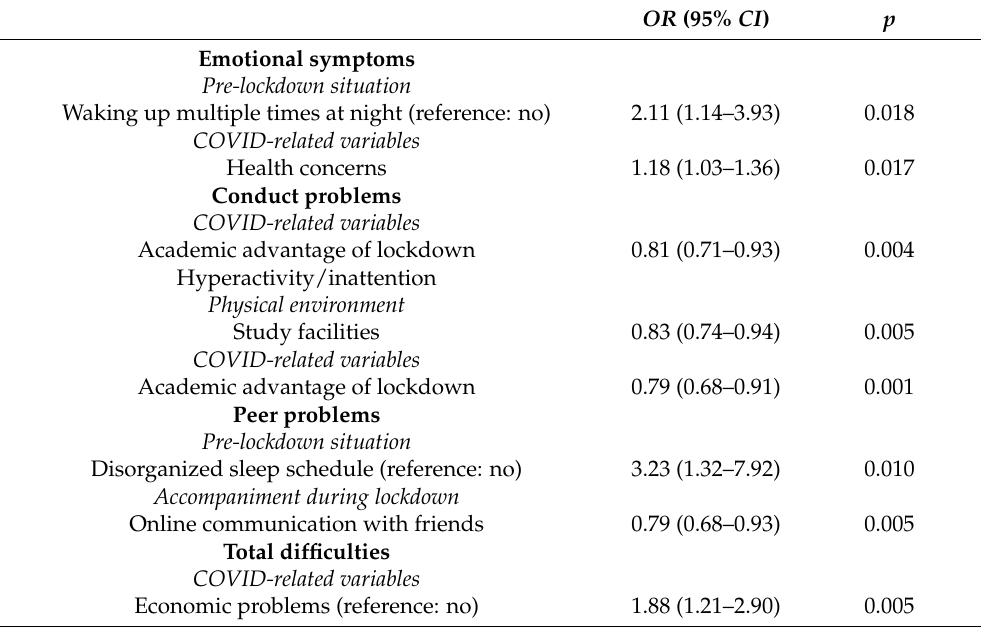
Table 4. Factors associated with impaired mental health during the COVID-19 lockdown according to adolescents ( N =